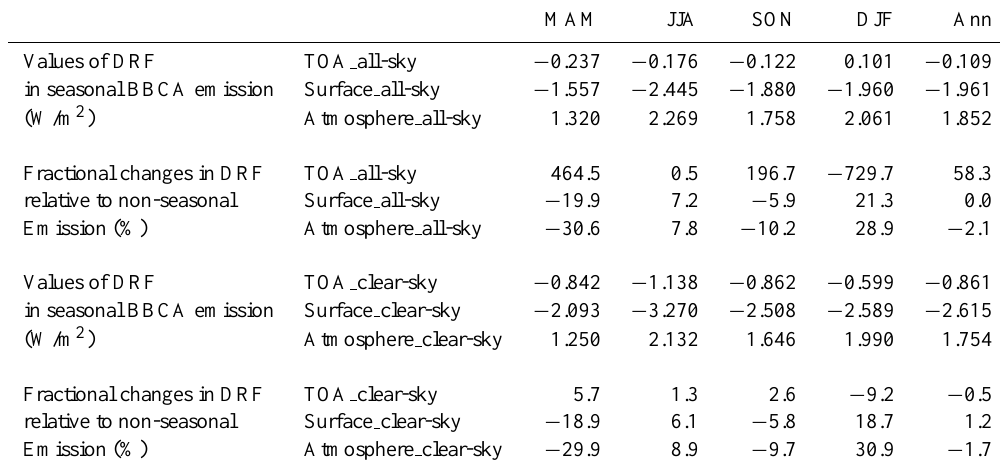
Table 1. Values of Direct Radiative Forcing (DRF) in seasonal emissions and differences in DRF due to seasonal BBCA emissions (offline runs). Top two rows show all-sky values; bottom two rows show clear-sky values.